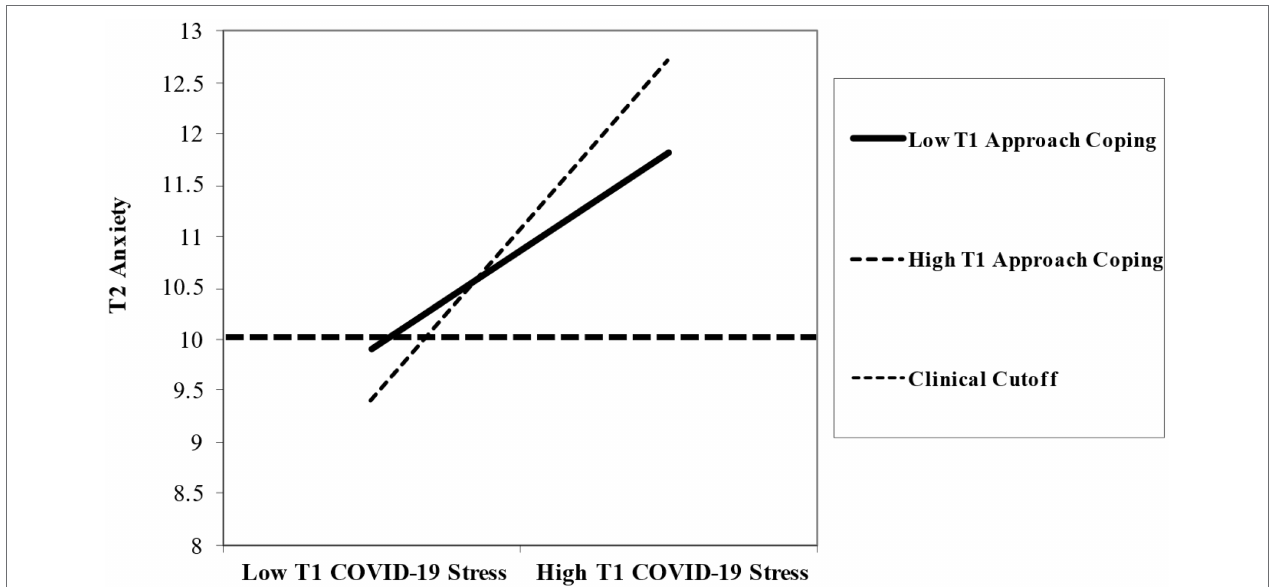
FIGURE 3 | Interaction between COVID-19 stress and approach coping predicting later anxiety.